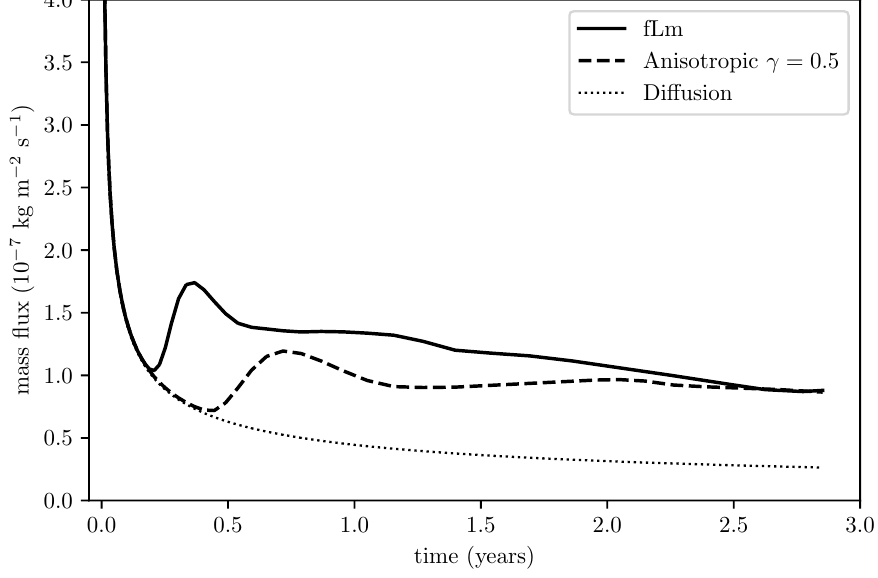
Figure 11. Dimensionless flux across the top boundary for the fractional Lévy motion model of permeability heterogeneity (solid line) and the equivalent anisotropic model with γ = 0.5 (dashed